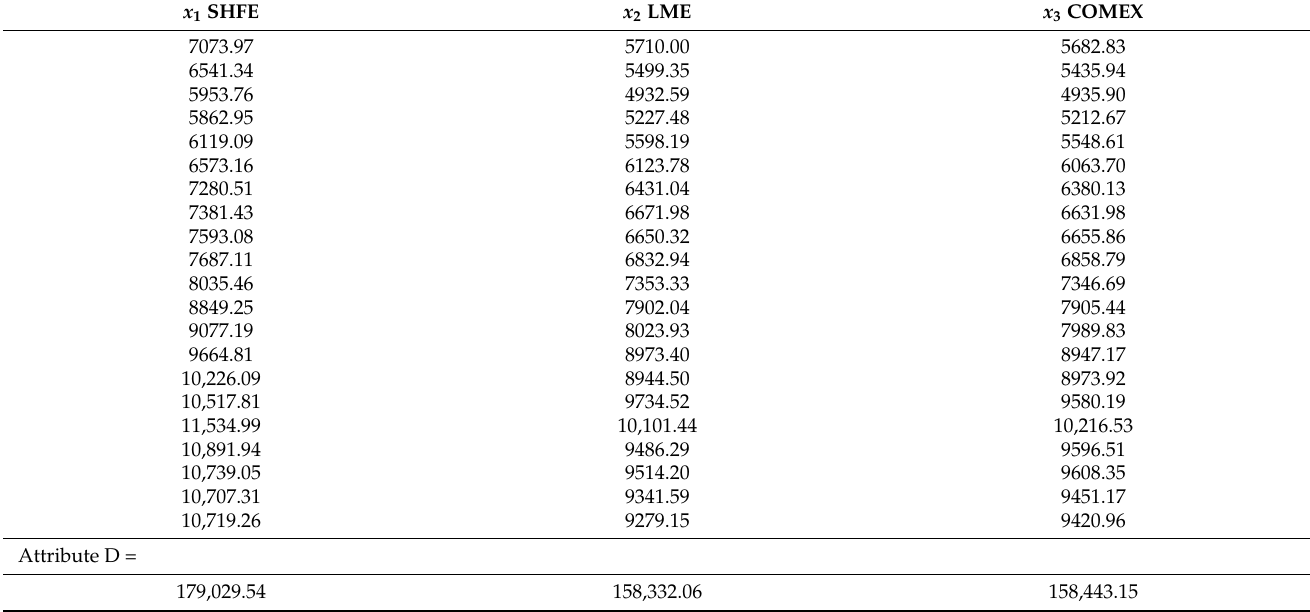
Table 3. Values of attribute “D” calculated using grey entropy and importing data from three copper futures markets after the COVID-19